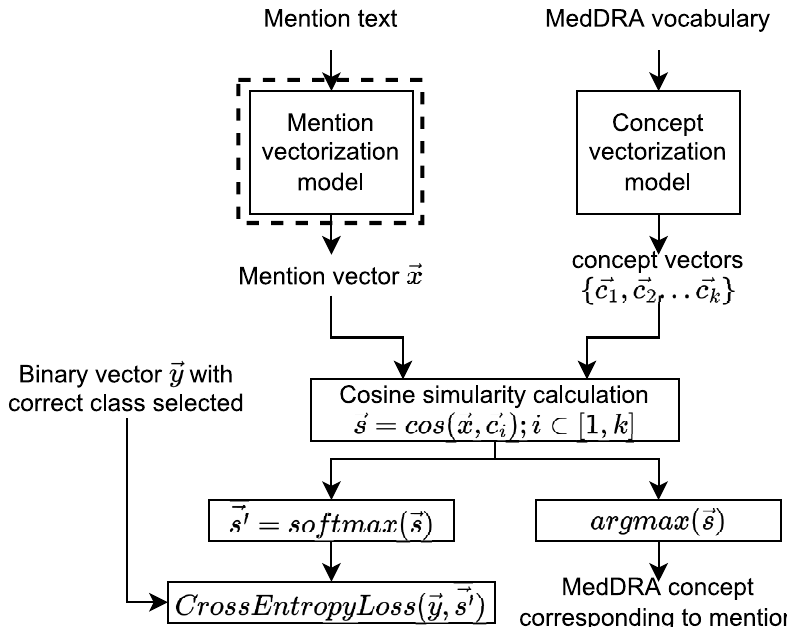
Figure 2. Architecture of the proposed model. Dotted line highlights the model with weights that tune during the